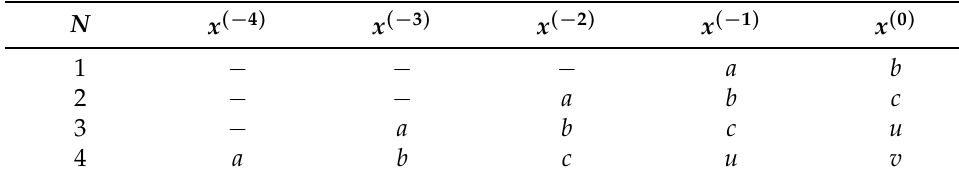
Table 2. Initial approximations for Example 1.